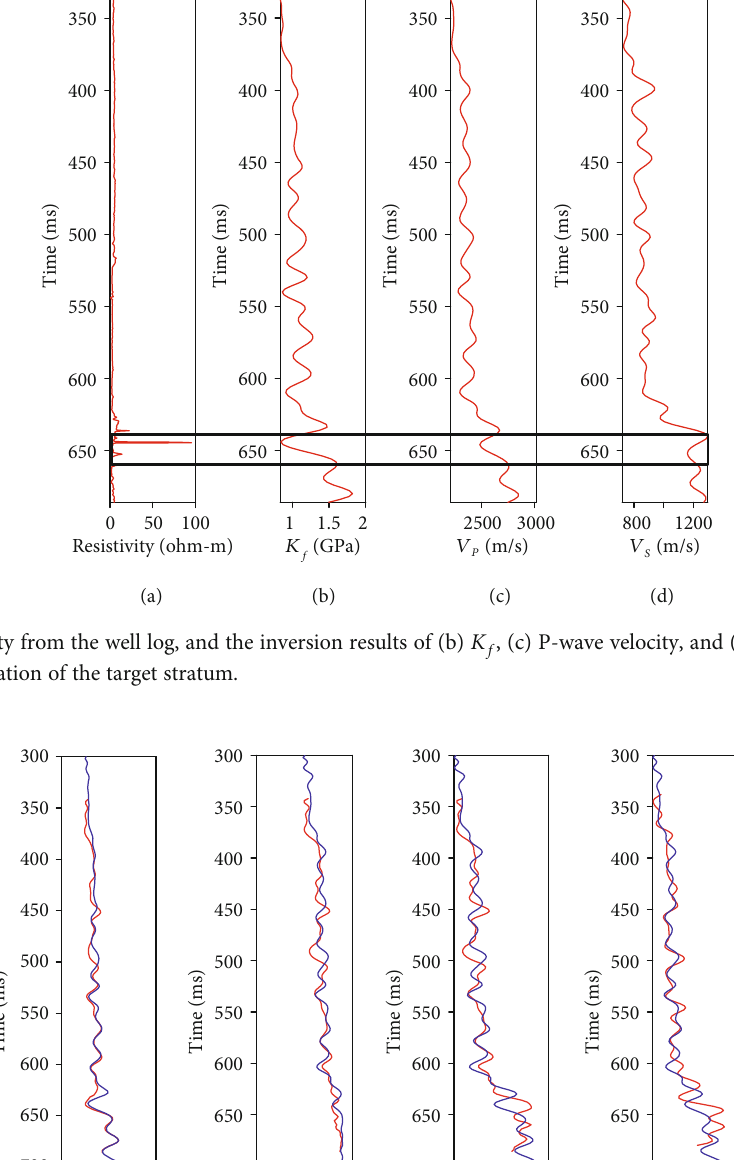
Figure 16: The comparison between the low-pass fi ltered parameters and the inverted parameters of (a) K The blue lines represent the inverted model and the red lines denote the low-pass fi ltered well log data with a high-cut frequency of 70-80 Hz. The correlation coe ffi cient between the inverted model and the well log data is 0.8924, 0.8567, 0.8824, and